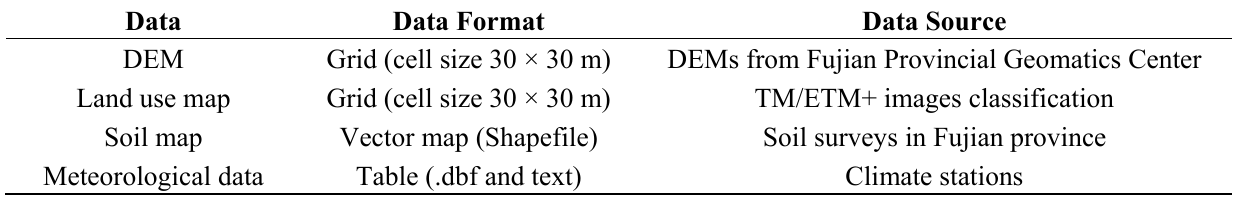
Table 1. Description of major input data for SWAT parameterization.